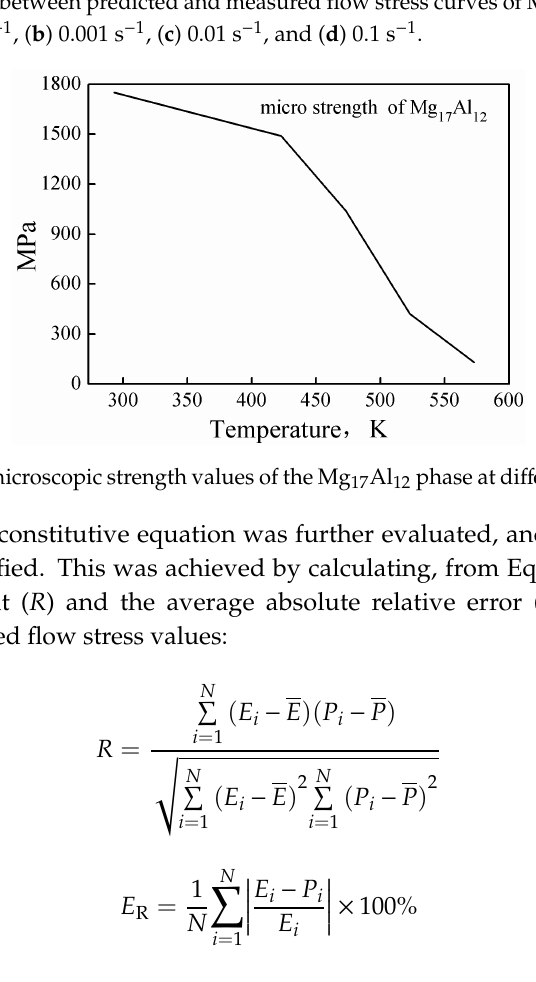
Figure 9. Comparisons between predicted and measured flow stress curves of Mg16Al alloy at different strain rate: ( a ) 0.0001 s − 1 , ( b ) 0.001 s − 1 , ( c ) 0.01 s − 1 , and ( d ) 0.1 s − 1 .